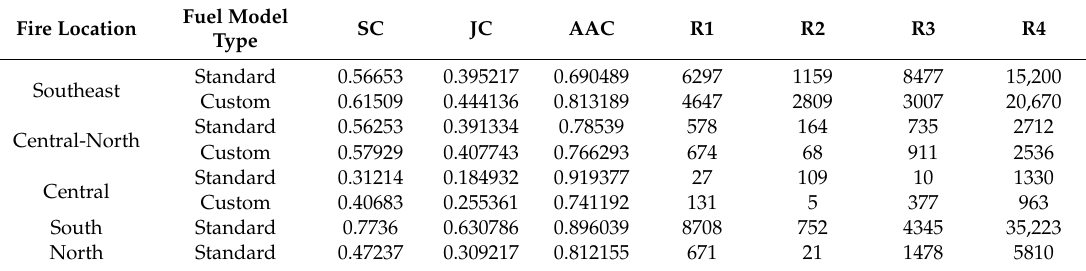
Table A4. Validation indices results from FARSITE simulations, comparing simulated with actual